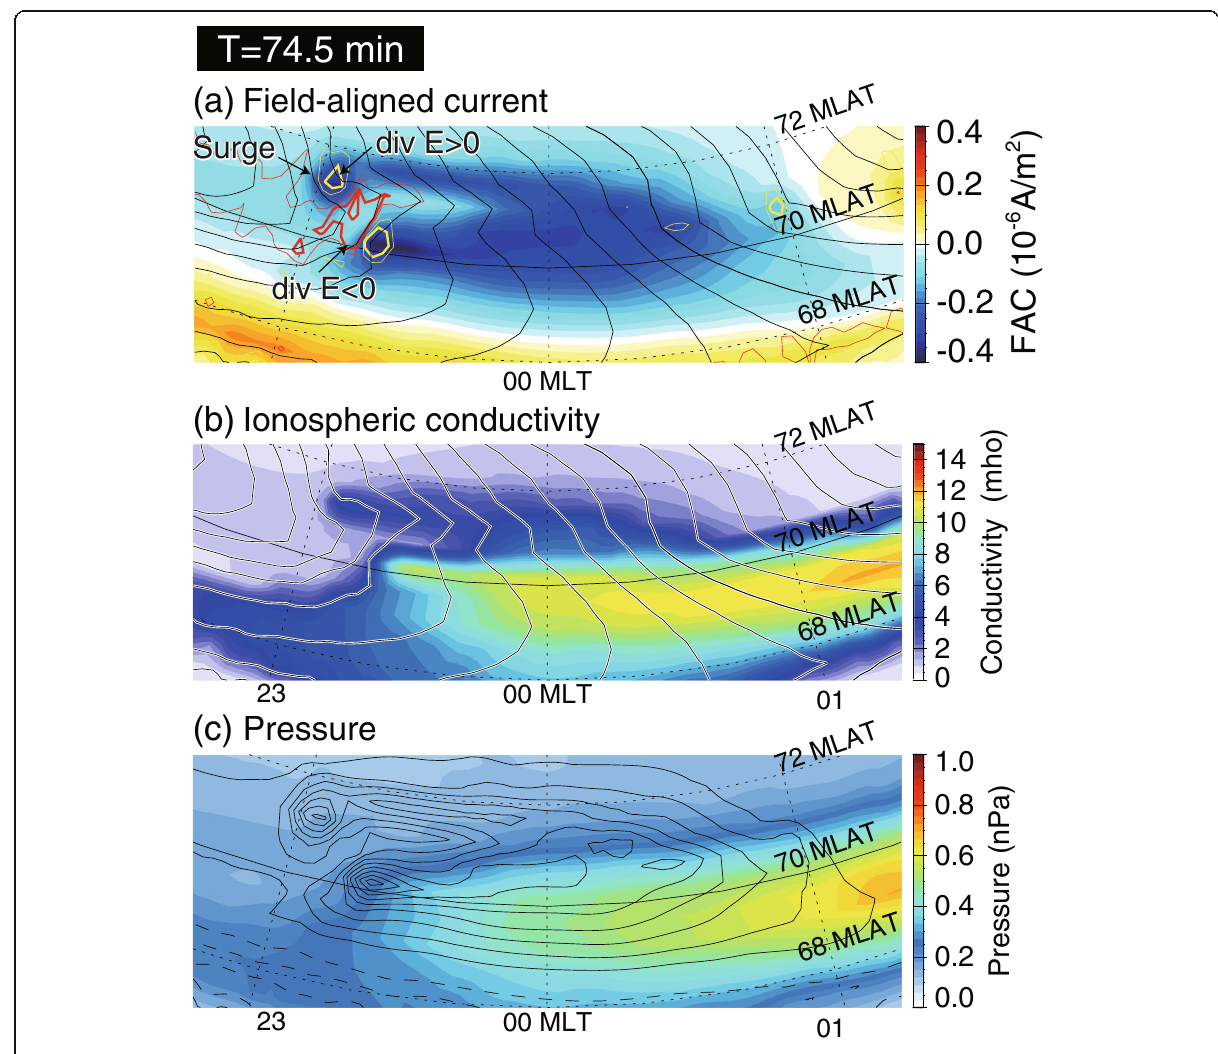
Fig. 12 a . Close-up views of the FACs, b . the ionospheric conductivity, and c . the magnetospheric pressure mapped to the ionosphere at T = 74.5 min. In a ., the yellow and red contour lines indicate the region where ∇ · E is positive (0.3 μ V/m 2 for thick line and 0.15 μ V/m 2 for thin line) and ∇ · E is negative ( − 0.3 μ V/m 2 for thick line and − 0.15 μ V/m 2 for thin line), respectively. E is the ionospheric electric field. The contour line in a and b indicates the ionospheric electric potential at interval of 1kV. The contour line in c indicates the FACs. (Adapted from Ebihara and Tanaka